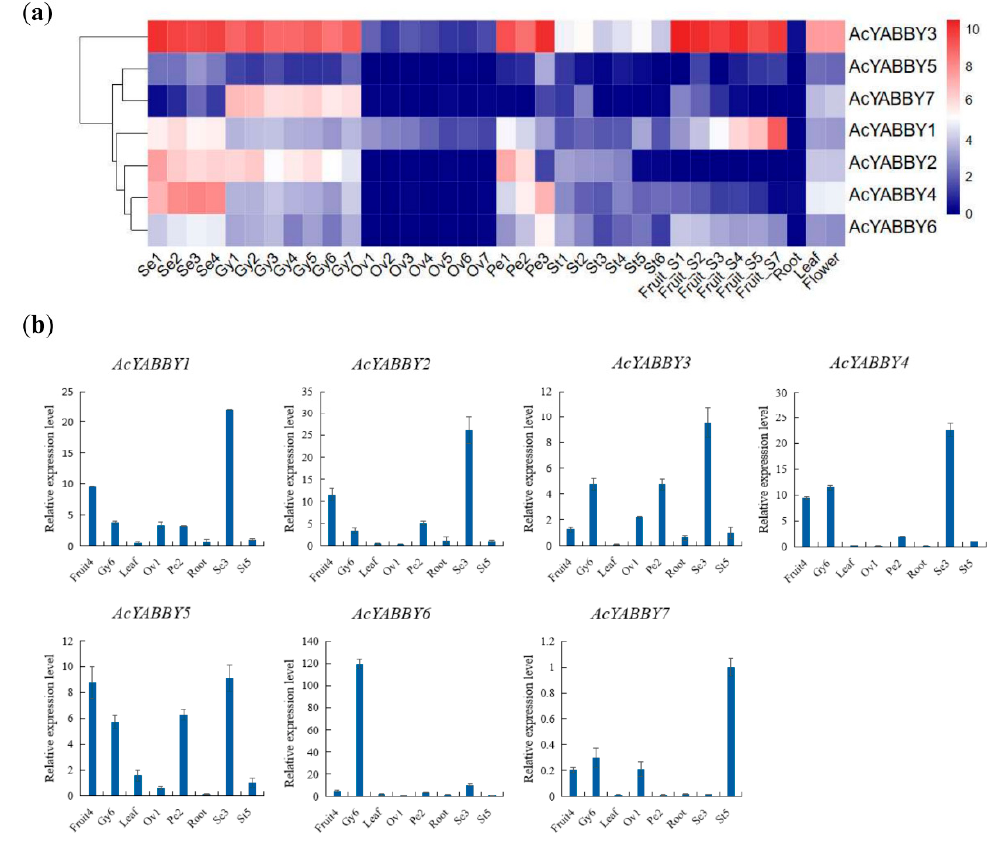
Figure 5. Expression profiles of the pineapple YABBY genes. ( a ) Heat-map of AcYABBY genes expression profiles in di ff erent tissue generated from RNA-seq data. The AcYABBYs were clustered according to their expression patterns. Red color indicates high levels of transcript abundance and blue indicates low transcript abundance. The color scale is shown on the right. Samples are mentioned at the bottom of each lane: Se (sepal) Se1-Se4, Gy (gynoecium) Gy1-7 Ov (ovule) Ov1-Ov7, Pe (petal) Pe1-Pe3, St (stamen) St1-St5, Fruit S1-S7, Root, Leaf, Flower. ( b ) Expression analysis of 7 pineapple YABBY genes in eight representative samples by RT-qPCR. RT-qPCR data were normalized using pineapple PP2A gene and vertical bars indicate standard deviation.